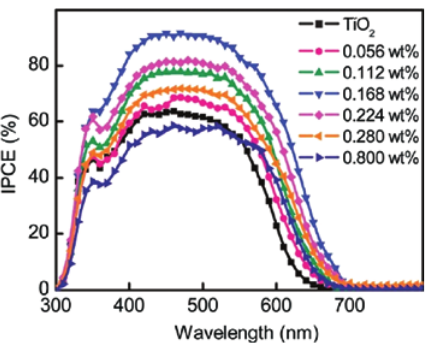
Figure 8: IPCE spectra of the DSCs based on FNE29 sensitized pure TiO , or Au–TiO (Au–TiO 0.056, 0.112, 0.168, 0.224, 0.280, and 2 2 2 0.800 wt%) films. Reproduced from [45] with permission of The Royal Society of